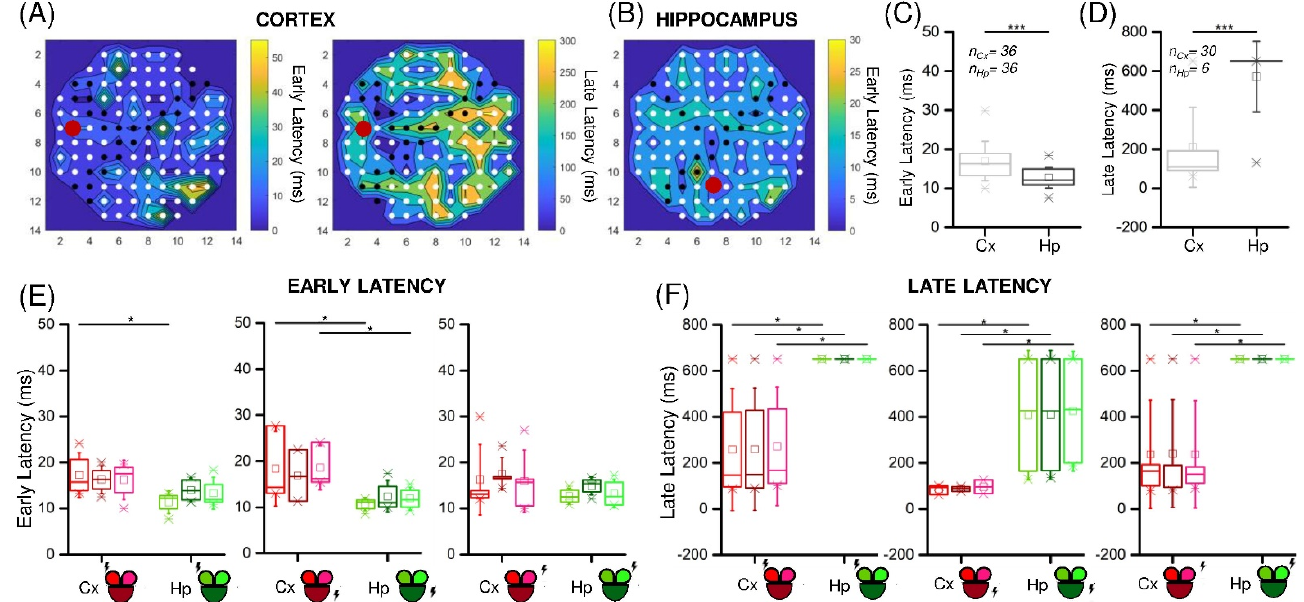
Figure 5. Cortical and hippocampal assemblies display different latency values when stimulated by low-frequency stimuli. Color-coded representation of the early and late (if present) latency values of representative ( A ) Cx and ( B ) Hp experiments. The red dot indicates the stimulated electrode. ( C , D ) Early and late latency cumulative values of Cx ( light grey ) and Hp ( dark grey ) assemblies. n Cx and n Hp indicate the number of evoked responses in the Cx and Hp configurations, respectively. ( E , F ) Relevance of the site of stimulation (highlighted with a lightning sign) in cortical ( red ) and hippocampal ( green ) networks in early and late latency values, respectively. (* refers to 0.01 < p < 0.05, *** to p < 0.001; Kruskal–Wallis nonparametric test).